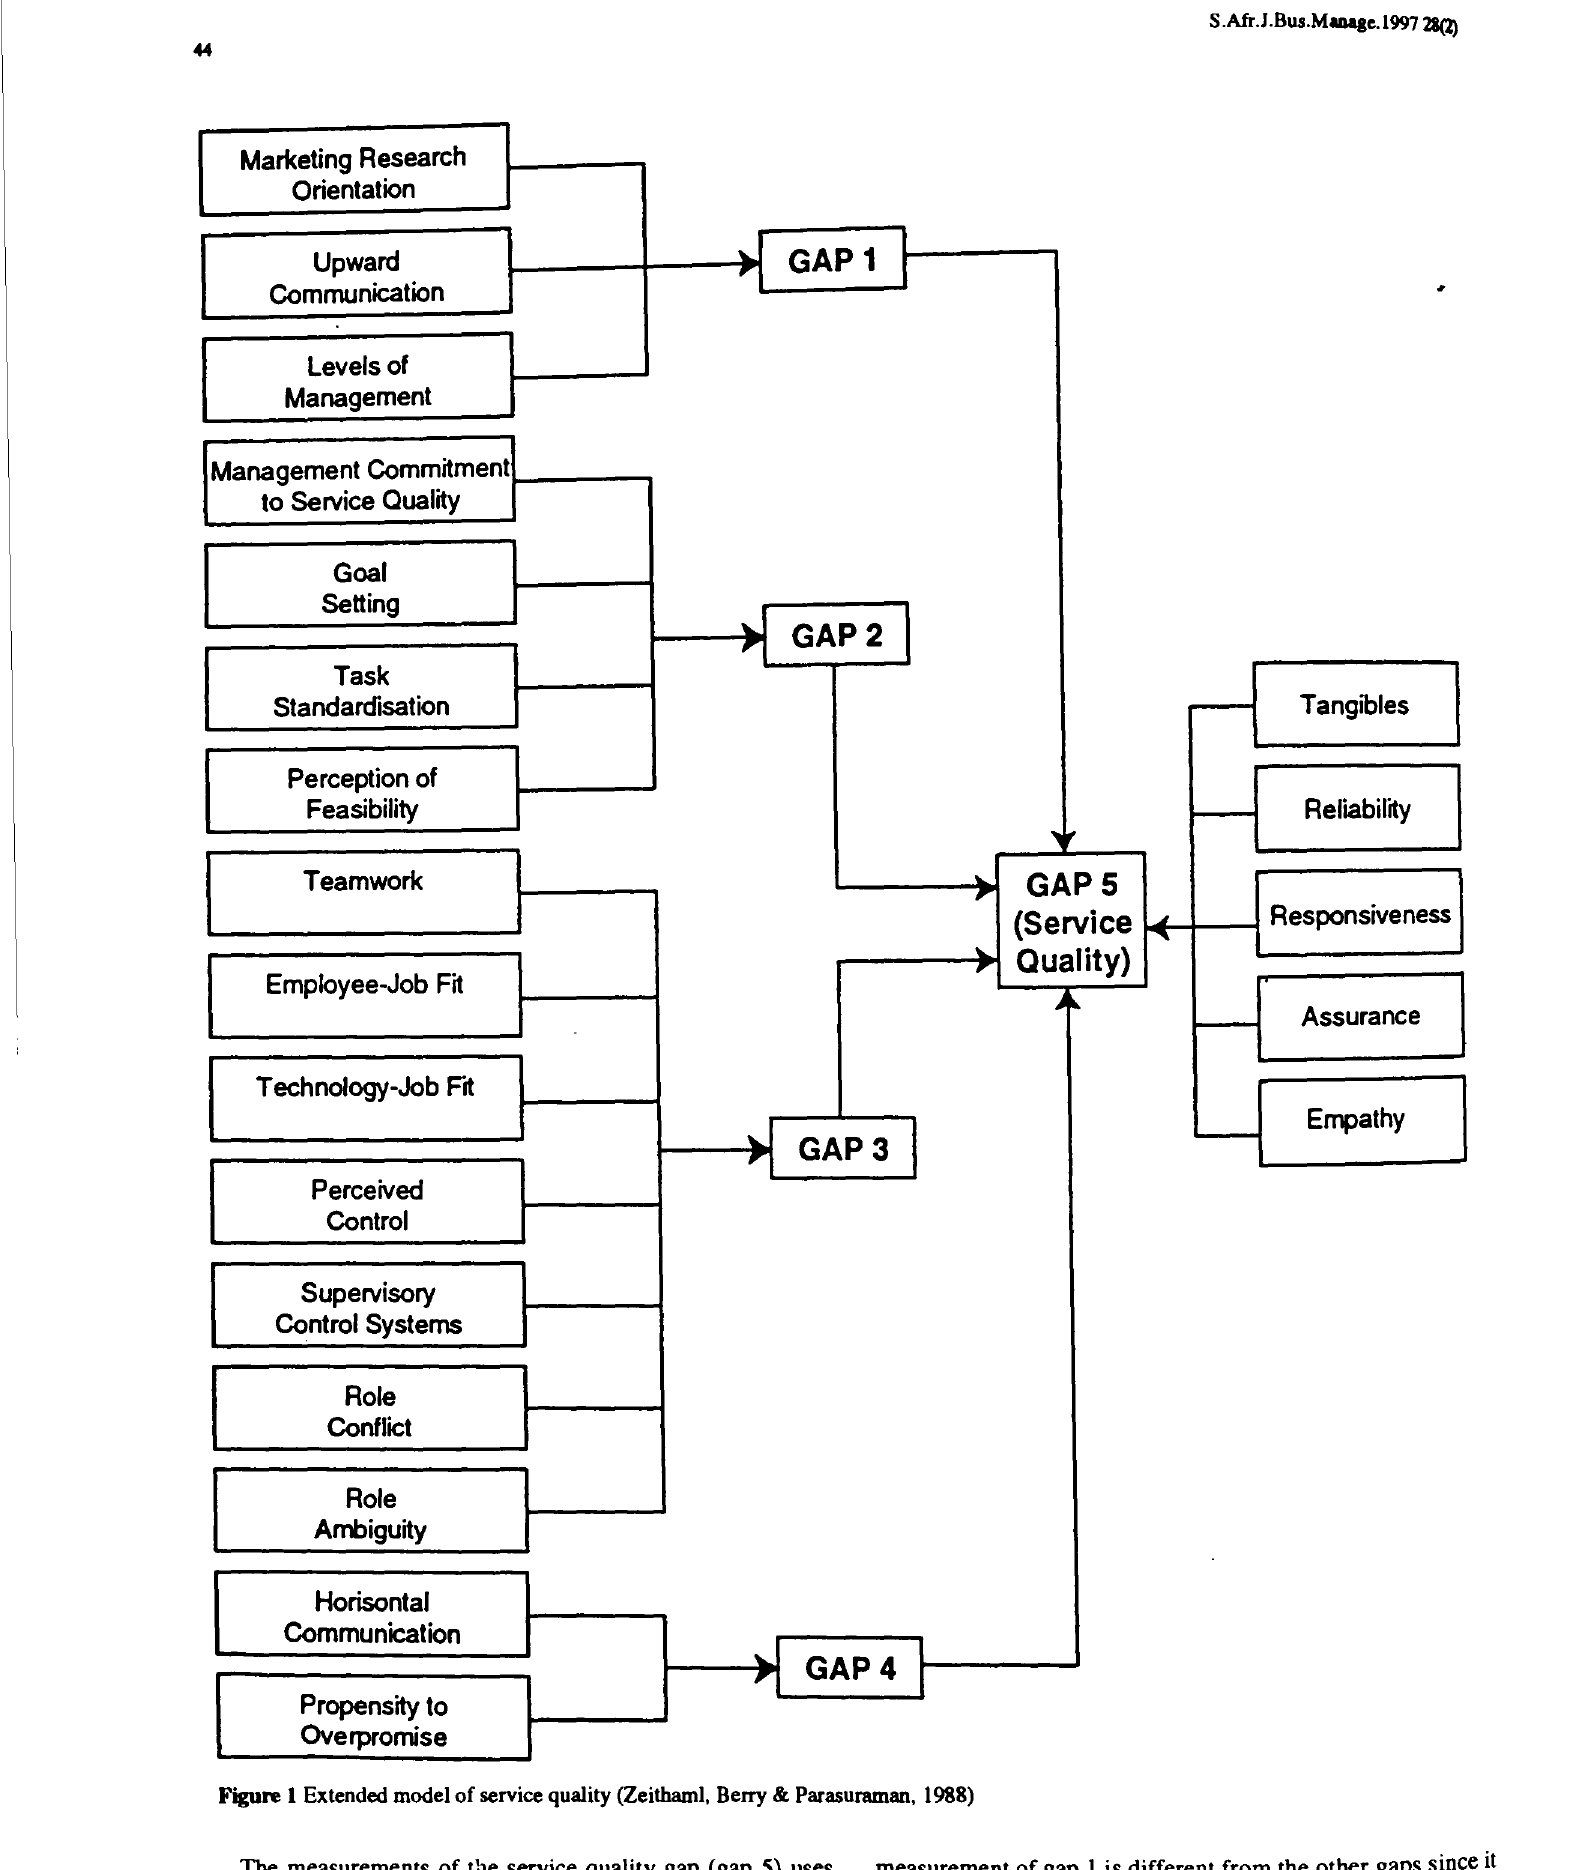
measurement of gap 1 is different from the other gaps since it crosses the boundary between the customer and the service provider in the conceptual model of service quality.